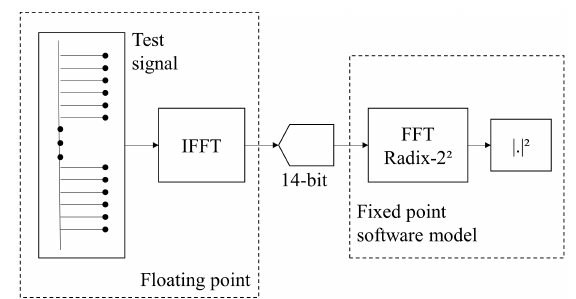
Figure 8. Slot noise test procedure - the bit size for the fixed- point FFT is increased until no further performance gain is noticeable in the calculated power spectrum.